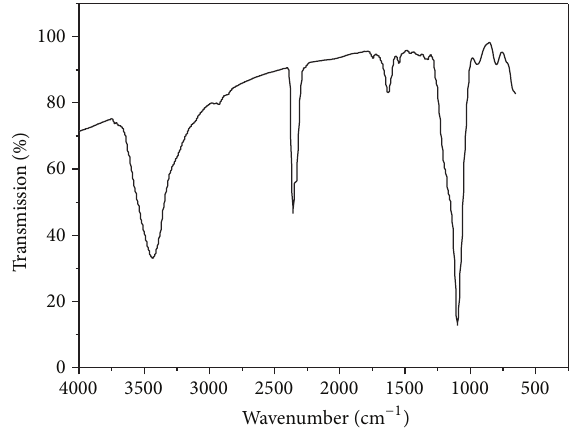
Figure 3: FTIR spectrum of TSF core-shell